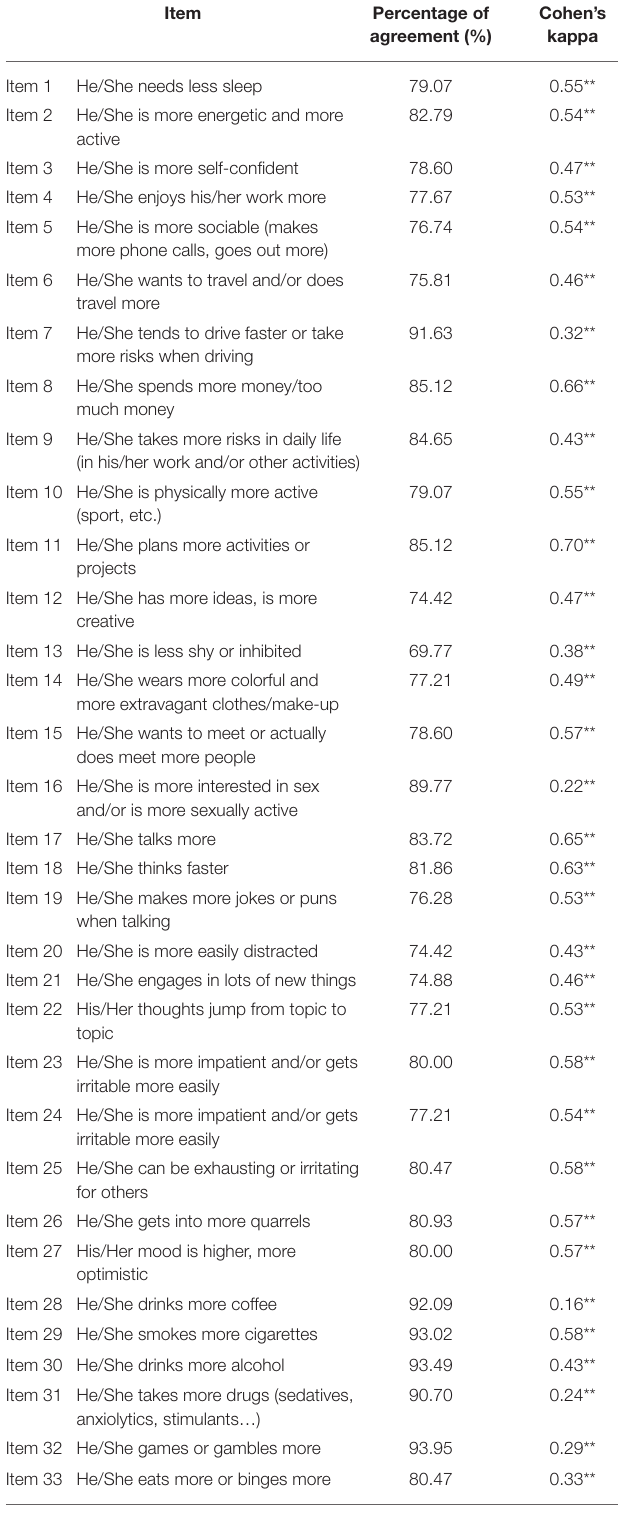
TABLE 2 | Consistency between the rating results of each item of the HCL-33 and HCL-33-EA.